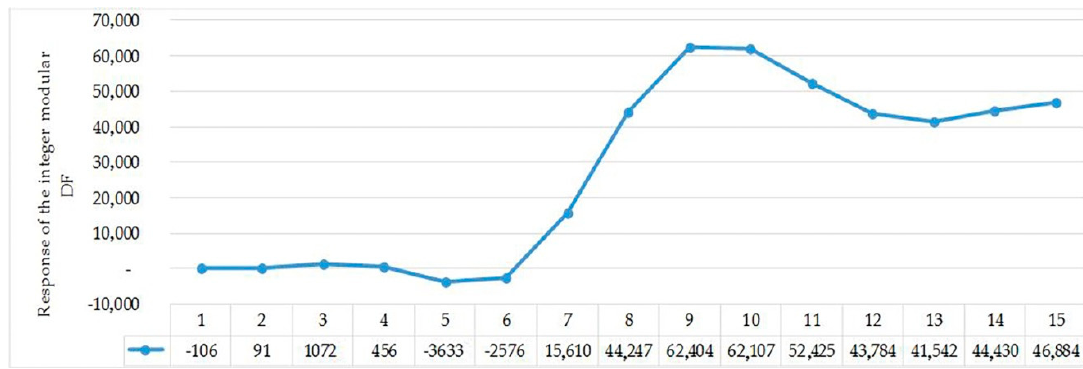
Figure 6. Response of the integer modular DF using scaling.